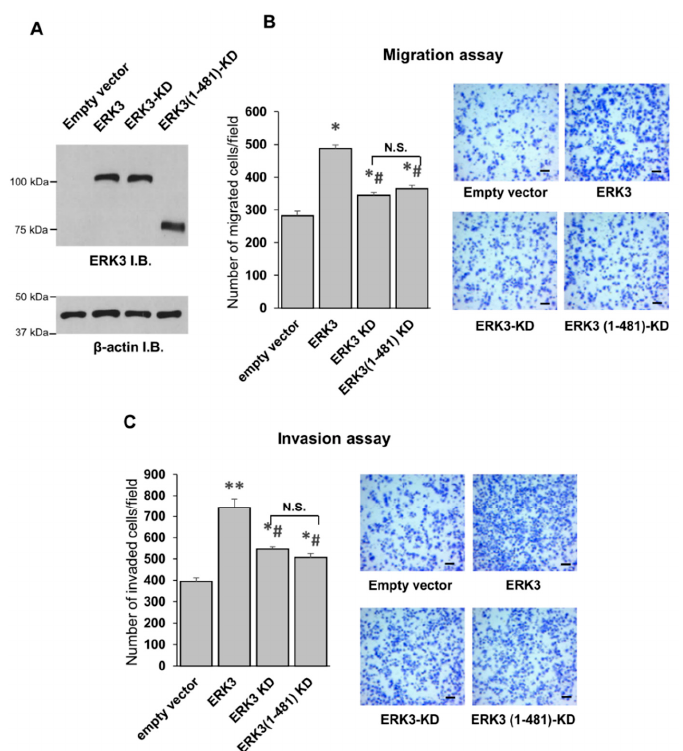
Figure 4. The C-terminus tail is important for the invasiveness-promoting ability of ERK3 through a kinase-dependent mechanism. ( A ) H1299 cells were transfected with an empty vector, ERK3, ERK3 kinase-dead (ERK3-KD) or ERK3 (1-481)-KD plasmids. Two days post-transfection, the cells were lysed and analyzed by Western blotting using an anti-ERK3 monoclonal antibody. Immunoblots (I.B.). ( B ) The migration ability of H1299 cells with overexpression of the indicated plasmids was determined by transwell migration assay. Values in the bar graphs represent mean ± SE ( n ≥ 6 fields). *: significantly di ff erent compared to empty vector ( p < 0.005); #: significantly di ff erent compared to ERK3 ( p < 0.0001); not significant (N.S.) by one-way ANOVA. Representative images of migrated cells stained with crystal violet are shown. Scale bar, 100 µ m. ( C ) The invasion ability of H1299 cells with overexpression of the indicated plasmids was determined by transwell Matrigel invasion assay. Values in the bar graphs represent mean ± SE ( n ≥ 6 fields). **: significantly di ff erent compared to empty vector ( p < 0.0001); *: significantly di ff erent compared to empty vector ( p < 0.05); #: significantly di ff erent compared to ERK3 ( p < 0.0001) by one-way ANOVA. Representative images of invaded cells stained with crystal violet are shown. Scale bar, 100 µ